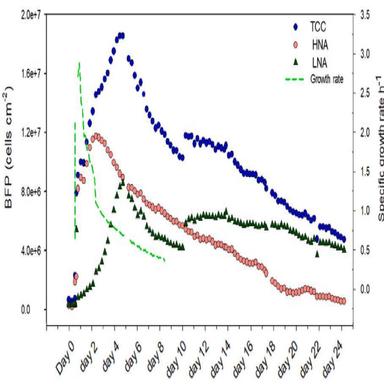
Semi-automated biomass formation potential (BFP) test using PVC-E. Total cell count (TCC) comprises high and low nucleic (HNA/LNA) bacteria and the bacteria growth rate in the PVC- E pipe.